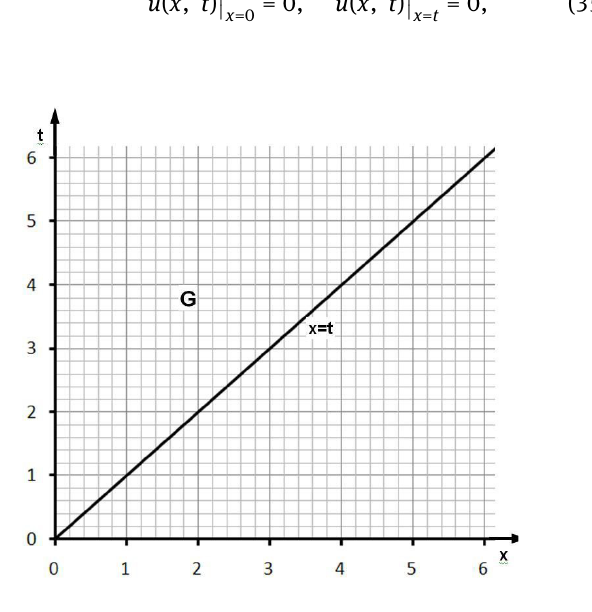
Figure 5: Infinite angular region